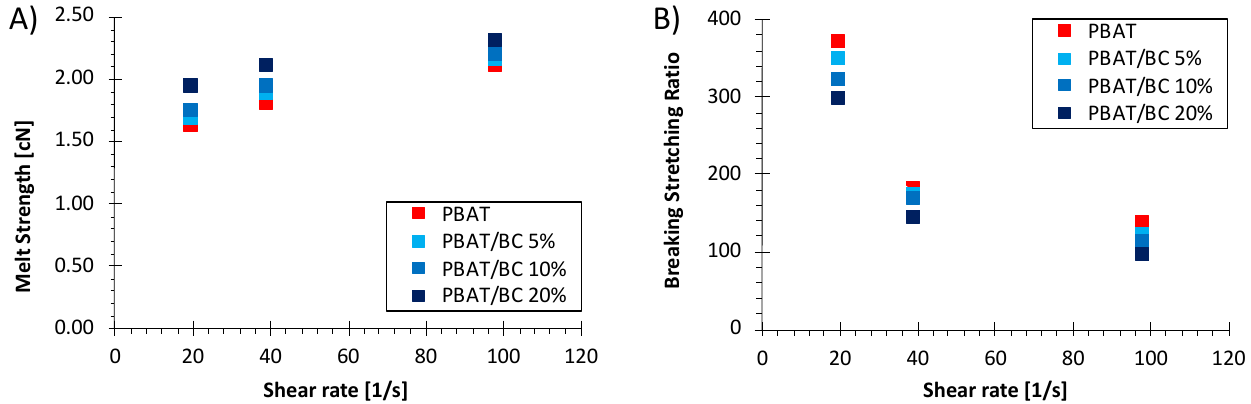
Figure 2. ( A ) Melt strength and ( B ) breaking–stretching ratio as a function of the apparent shear rate of PBAT and PBAT/BC biocomposites.